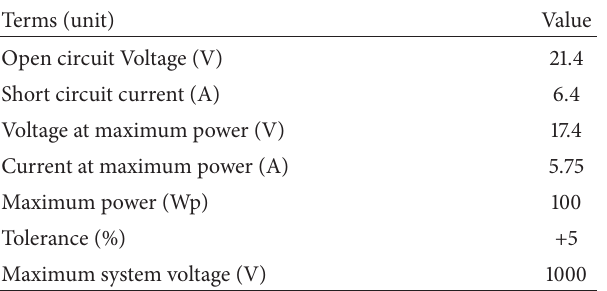
Table 1: Monocrystalline PV module specifications at standard test conditions.